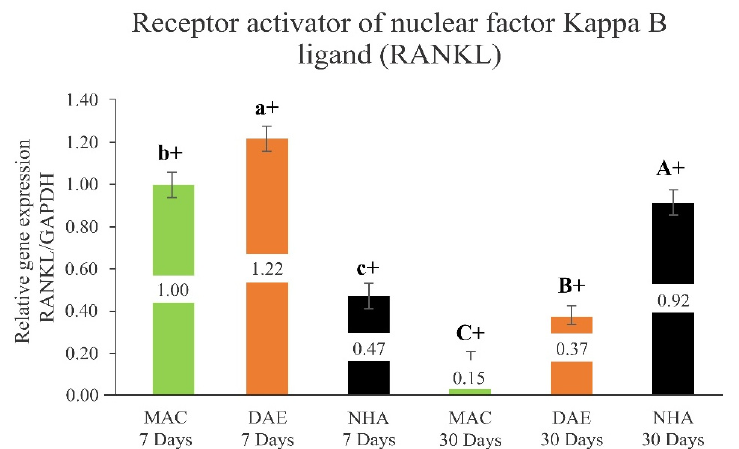
Figure 8. Relative expression of the activating receptor of nuclear factor Kappa ligand (RANKL)/GAPDH (RANKL/GAPDH) in all groups (mean + 95% confidence interval). Lower case letters represent the analysis of 7 days, and capital letters the analysis of 30 days. Different letters indicate a statistically significant difference between groups. The + sign indicates a statistically significant difference (MAC: p < 0.001; DAE: p < 0.001; NHA: p < 0.001) for intragroup analyses, considering the same surface treatment and different assessment times.